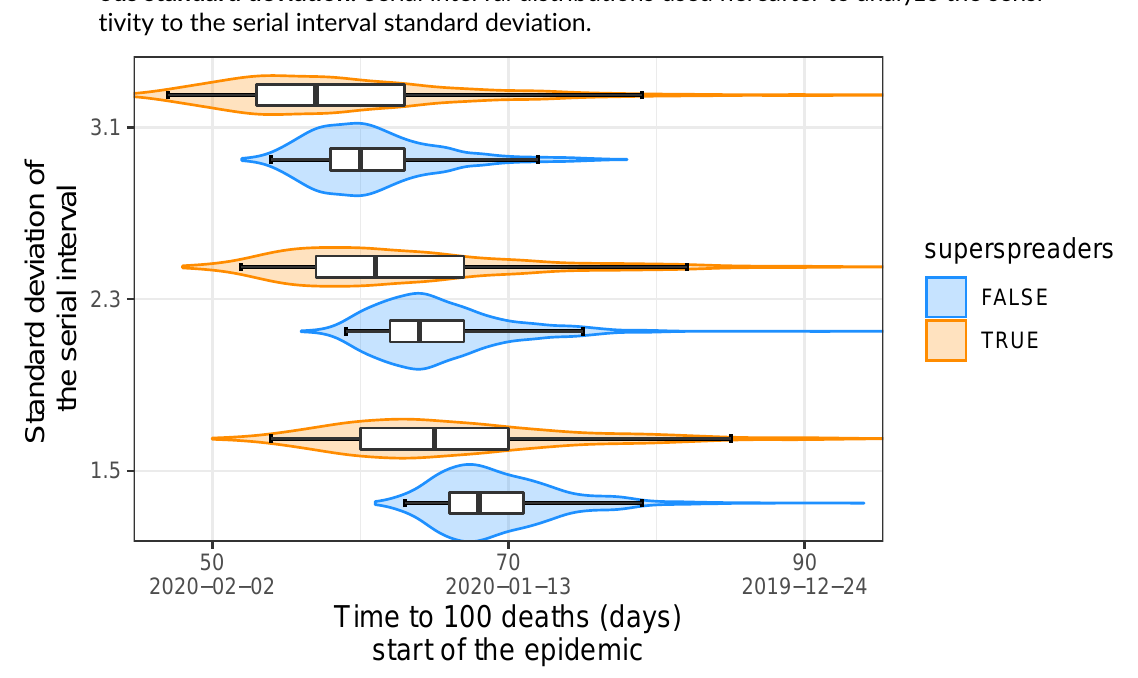
Figure S5 – Time to 100 deaths distributions for various standard deviation of the se- rial interval distribution. We remind that all serial intervals share similar mean following (Nishiura, Linton, et al., 2020) estimations. The boxplots show the following quantiles: 2.5%, 25%, 50 %, 75%, 97.5 %. An increase in the standard deviation of the serial inter- val distribution shorten the time to 100